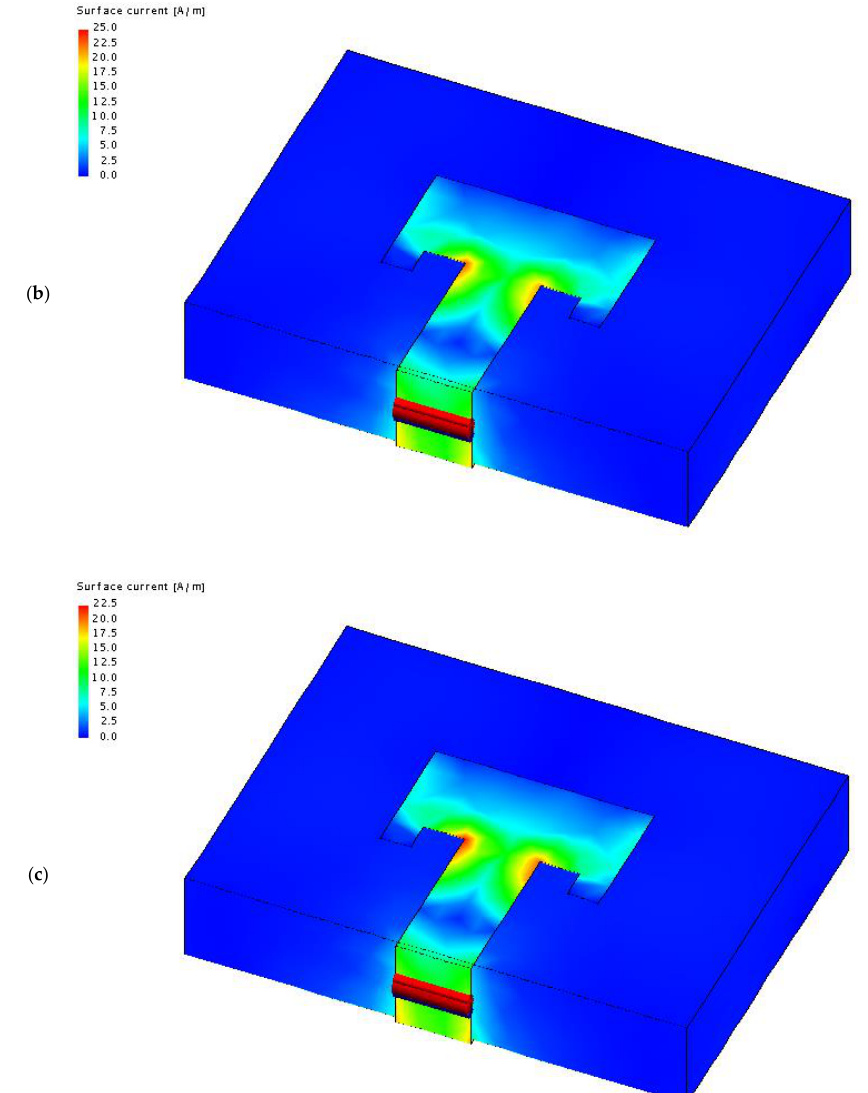
Figure 9. Surface current distribution for the proposed 5G antenna at different frequencies. ( a ) 27.51 GHz; ( b ) 28.0 GHz; ( c ) 28.35 GHz.